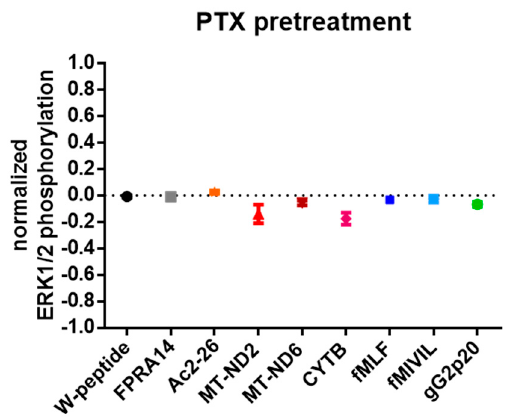
Figure 5. FPR1-mediated ERK1/2 phosphorylation is abolished in PTX (pertussis toxin)-pretreated cells. Cells were pretreated for 16 h with 100 ng/mL PTX and subsequently stimulated with agonist concentrations eliciting the respective E max . Results were normalized to the maximum system response obtained with PMA. Data points represent the mean ± SEM of 6 independent measurements.